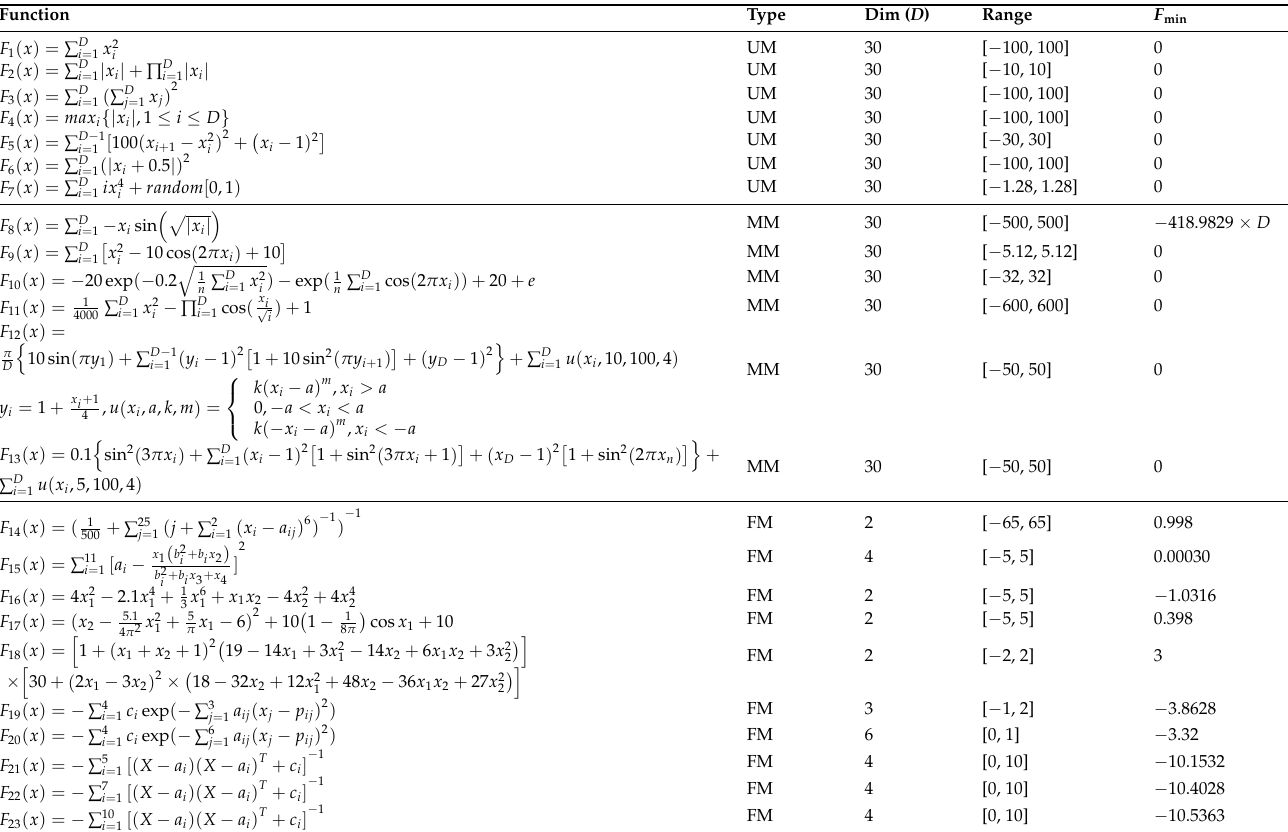
Table 4. Characteristics of the 23 classical benchmark functions (UM: unimodal, MM: multimodal, FM: fix-dimension multimodal, Dim: dimension, Range: search boundaries, F min : theoretical optimal